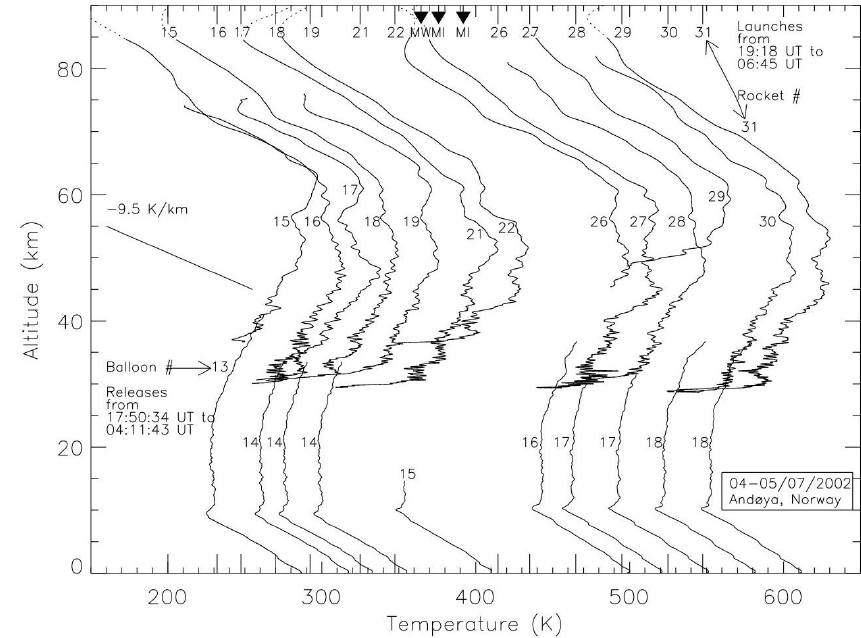
Fig. 8. Waterfall plot similar to Fig. 7, but for the July 4-5, 2002 sequence at ARR.